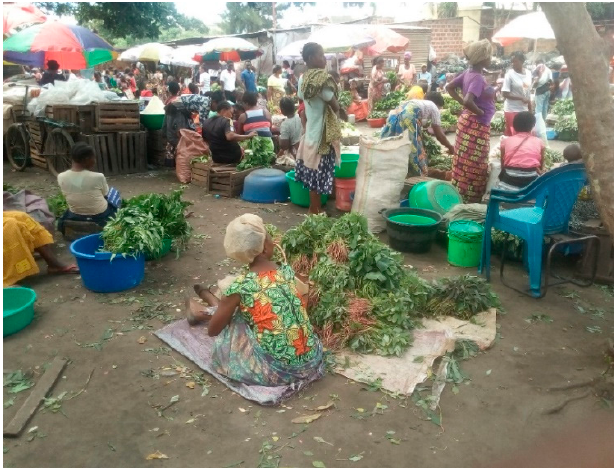
Figure 2. Food section in a public market in Kolwezi, Democratic Republic of Congo.